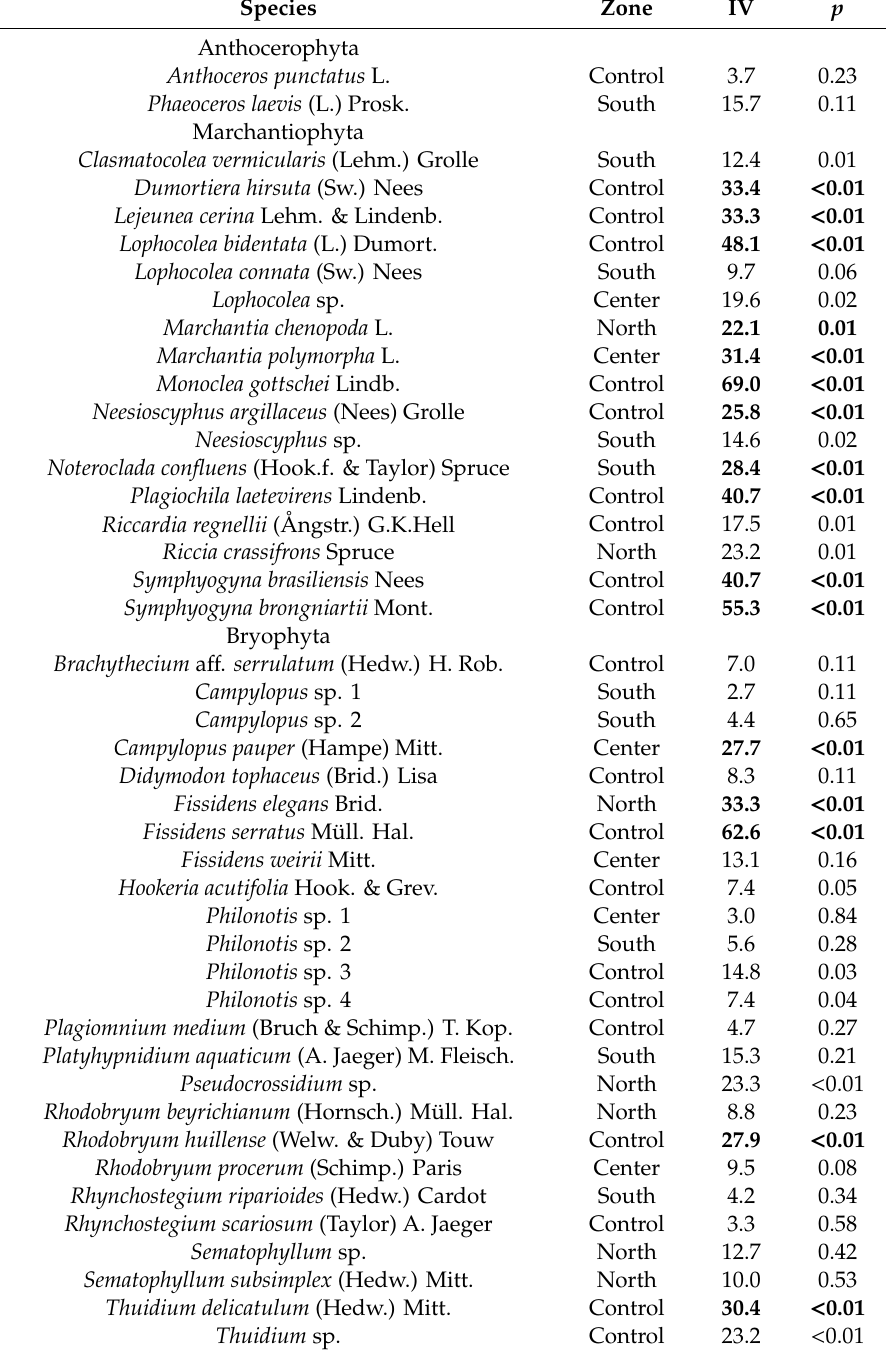
Table A1. Indicator values (IV) for bryophyte species. Species with indicator value > 25 are considered as the best indicators. Species with both high indicator value and a significant p value ( p < 0.05) are shown in